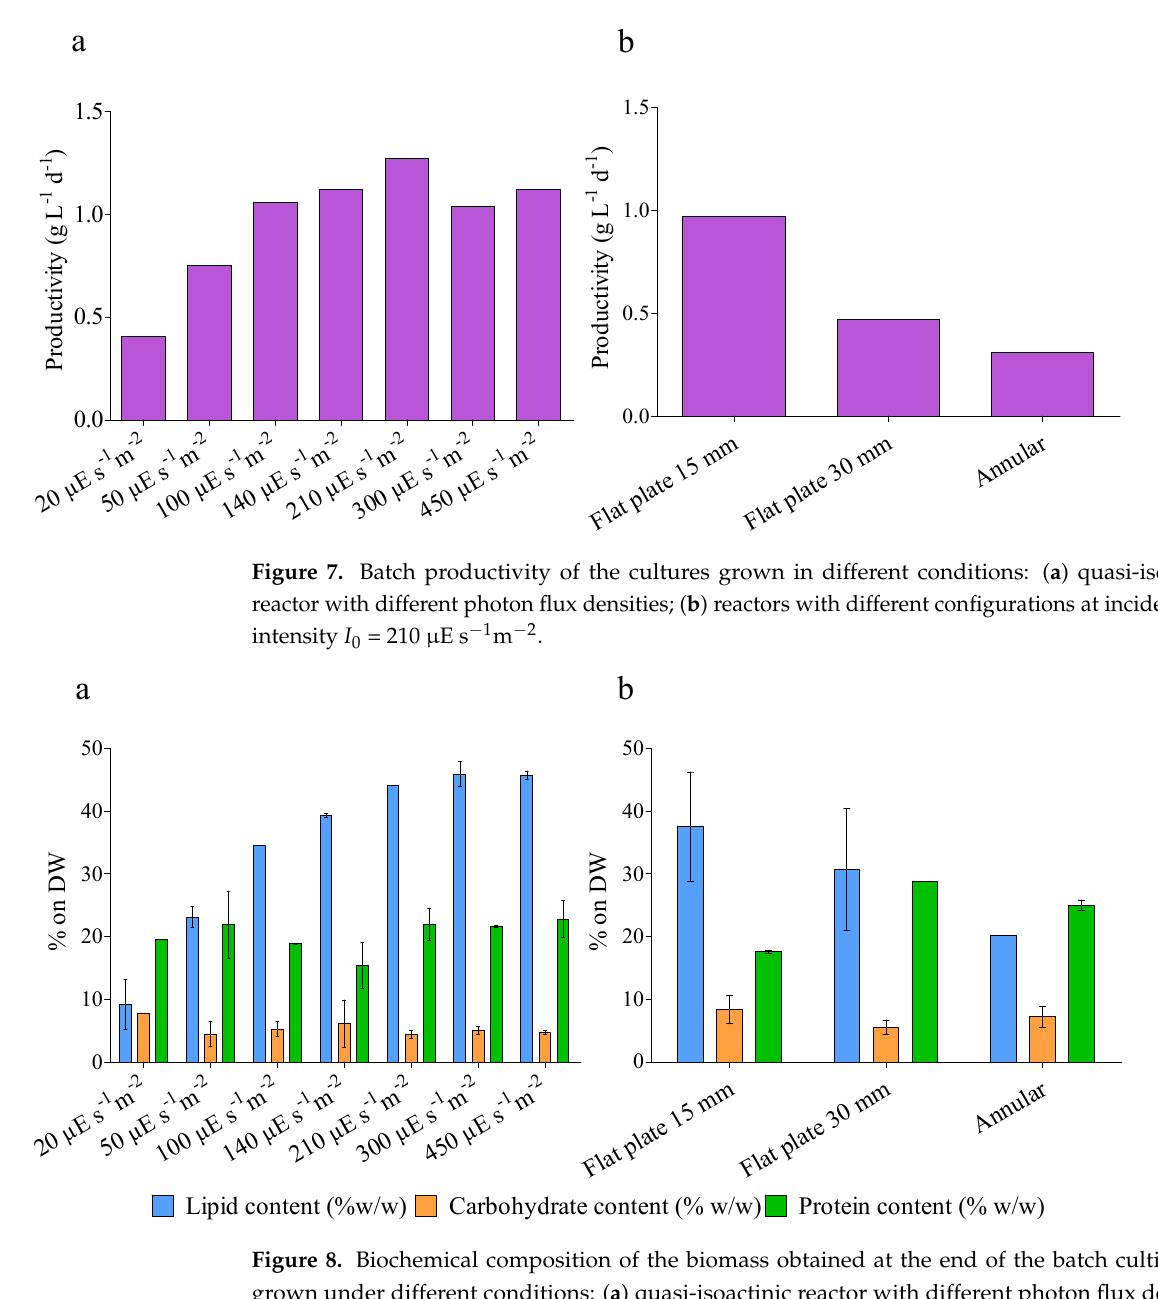
Figure 9. Fatty acid analysis as percentage of total fatty acid content in the biomass obtained at the end of the batch cultivations grown under different conditions: ( a ) quasi-isoactinic reactor with dif- ferent photon flux densities; ( b ) reactors with different configurations at incident light intensity I 0 = 210 µE s − 1 m − 2 . SFA, saturated fatty acid; MUFA, monounsaturated fatty acids; PUFA: polyunsatu- rated fatty acid. Figure 8 shows the biochemical composition of the biomass obtained at the end of the batch cultivations and grown under different photon flux densities (Figure 8a) and in reactors with different configurations (Figure 8b). Lipid content shows a defined trend between the analysed conditions, while carbohydrate and protein content do not. Carbo- hydrate content is on average around 8% of the dry weight, while protein content is on average around 20% of the dry weight, as previously determined in the same strain [27].